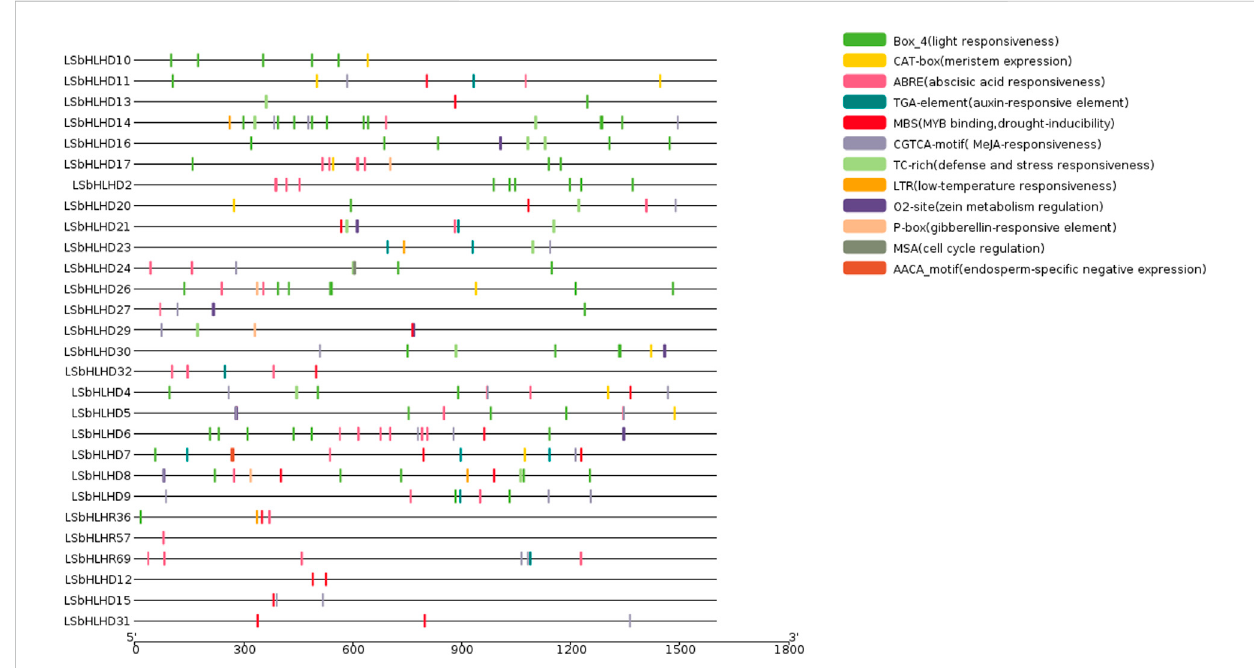
FIGURE 2 Thecis-elementsidenti fi edinthepromoterregionsof28bHLHgenesingrasspea.Thepromoterregions,1,500bpupstreamofthegenestartsites, were analyzed using the PlantCARE software to predict potential cis-regulatory elements. The elements related to cell cycle regulation, meristem- endosperm expression, metabolic regulation, and responses to various plant hormones (abscisic acid, auxin, methyl jasmonate, gibberellic acid, and salicylic acid) and environmental stimuli (anaerobic induction, light, low temperature, and drought) are depicted in different